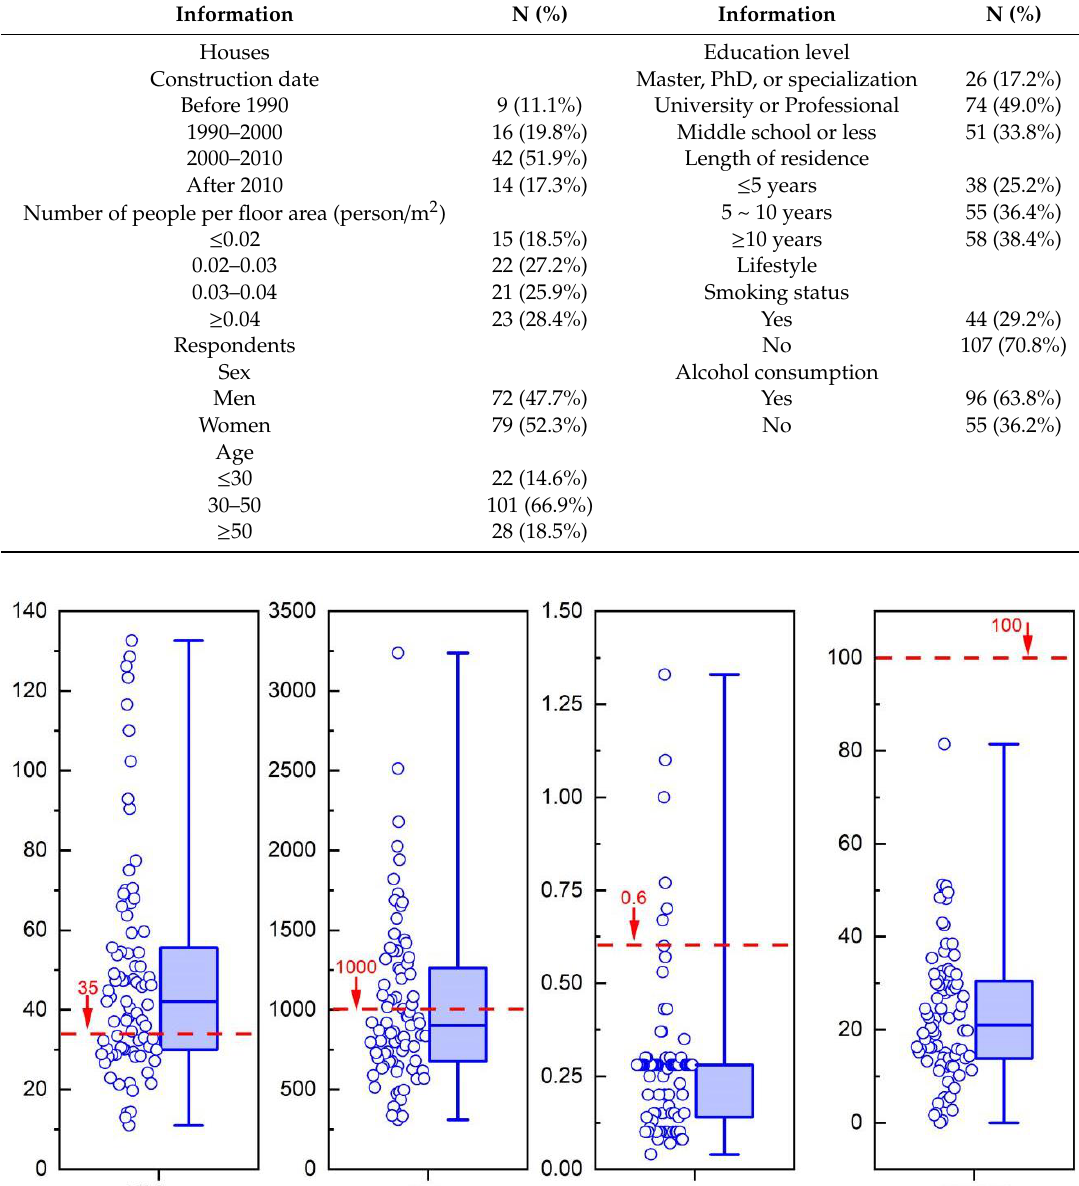
Table 3. The information on the houses measured and respondents.